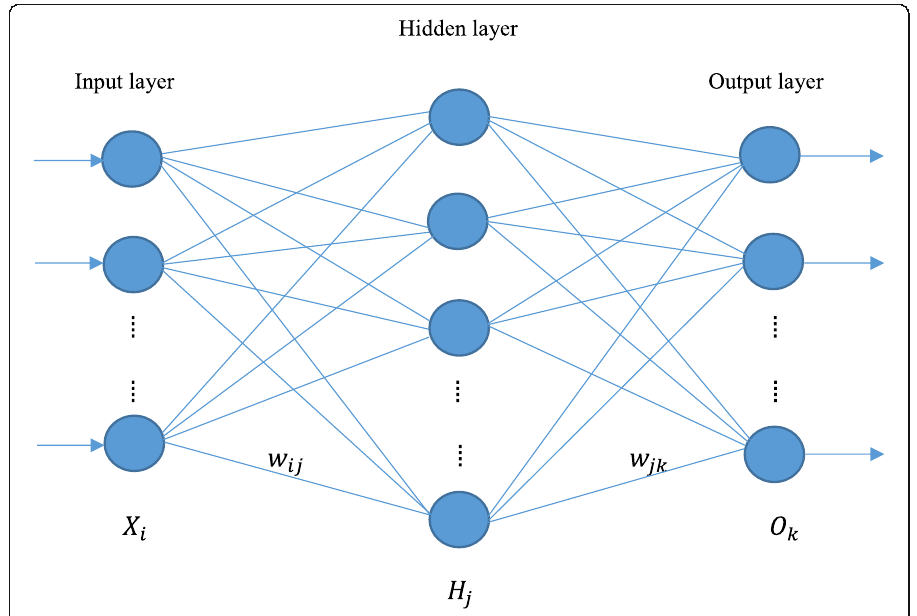
Fig. 2 Topology of a multilayer feed-forward neural network used for